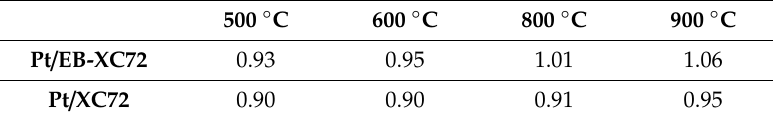
Figure 5. Raman spectra of ( a ) Pt / XC72 and ( b ) Pt / EB-XC72. Table 2. I D /I G value of various Pt-catalysts.